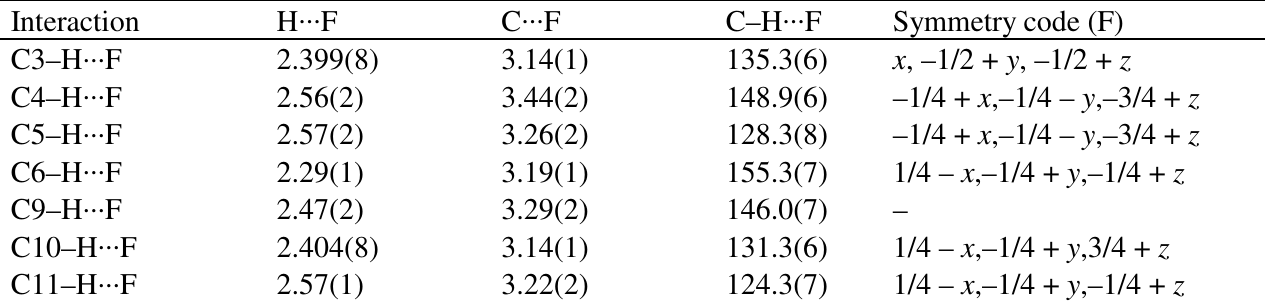
Table 1. Distances and angles for the short C–H...F contacts (Å,°) in the structure of 2